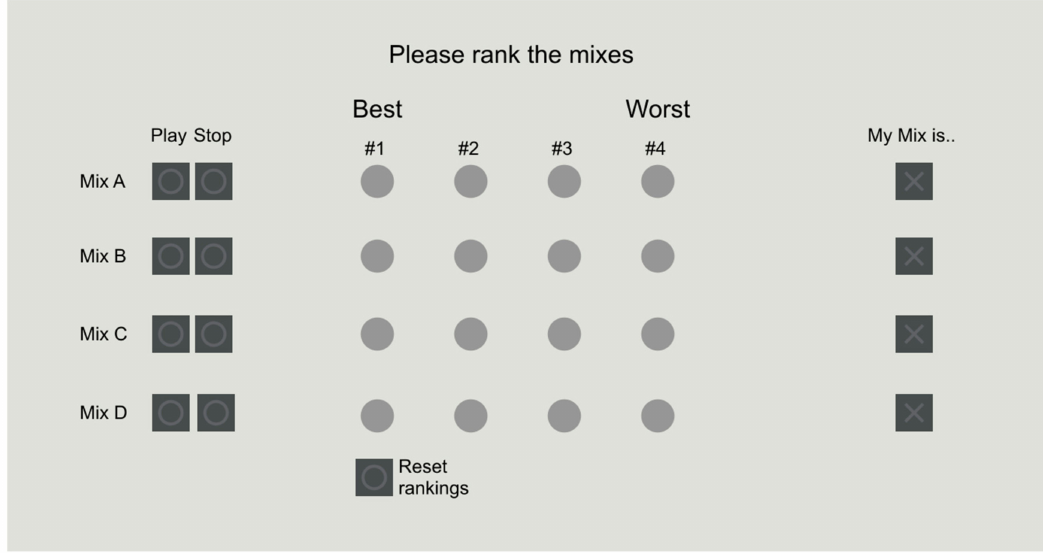
Figure 3. Screenshot of ranking interface for a single musical